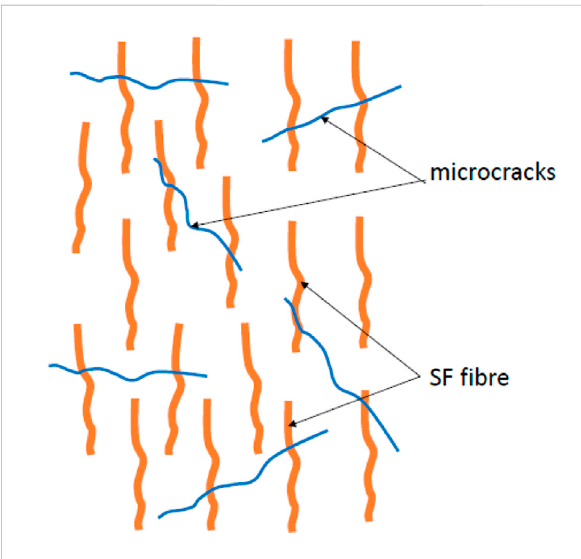
FIGURE 13 SF function as a fastener when the FC develops a microcracks.